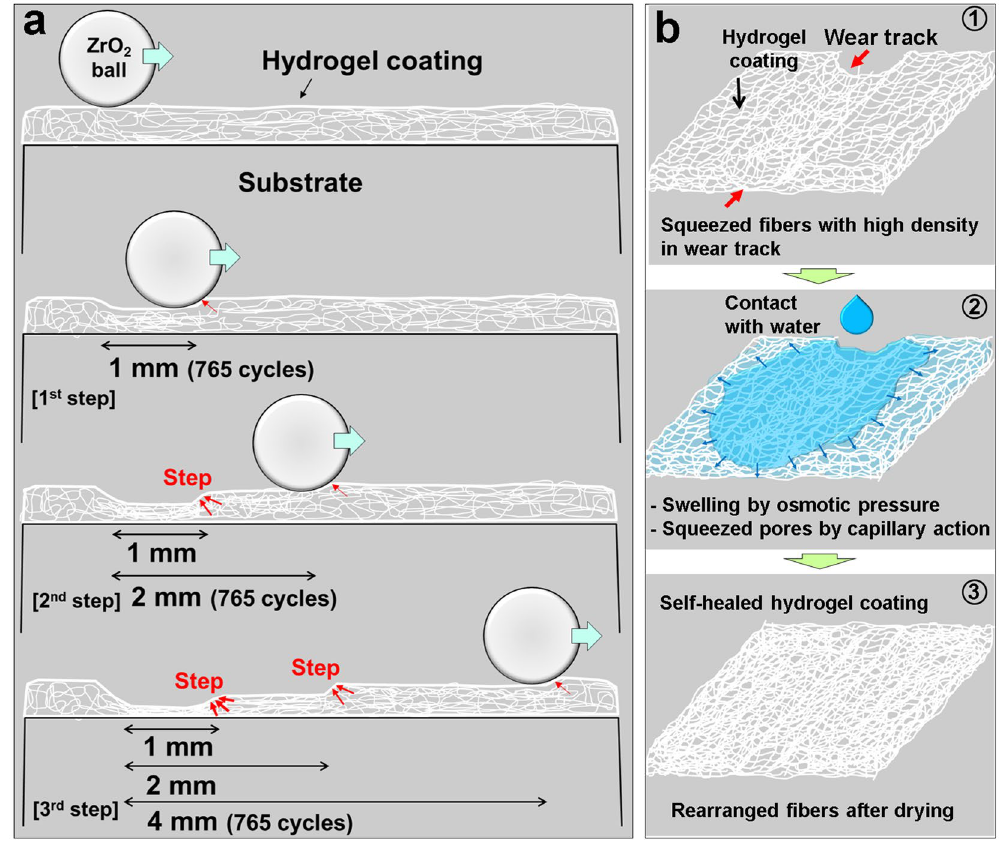
Figure 5. Mechanism and process of wear and self-healing of hydrogel. ( a ) Schematic of the wear track generation of the hydrogel coating with respect to the sliding stroke. Red arrows indicate the force concentration. ( b ) Schematic of the self-healing mechanism and process of wear track formation on the hydrogel coating surface. ① Wear track with compressed fibers generated on the hydrogel coating surface; ② After hydration, the fibers swell by osmosis and pores among the fibers are compressed by capillary action; ③ After drying, the fibers were reconstituted with self-healing. Red arrows indicate the wear